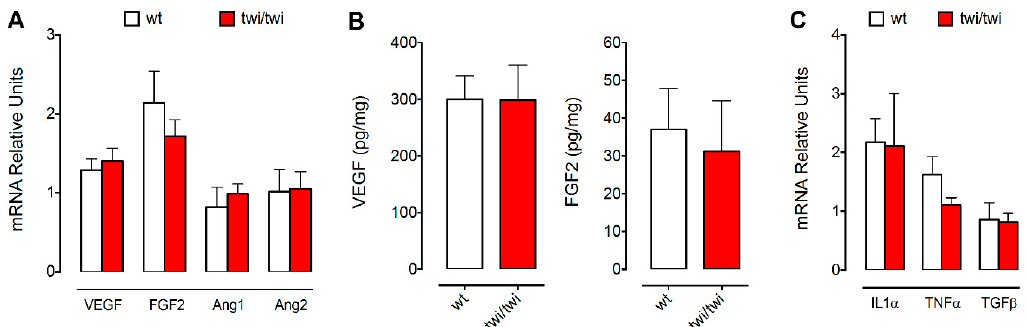
Figure 6. Quantification of pro-angiogenic and pro-inflammatory cytokines in the BM of twitcher mice. Pro-angiogenic ( A , B ) and pro-inflammatory cytokines ( C ) were quantified after BM flushing by ELISA ( B ; 3 animals per group) and RT-qPCR ( A , C ; 7–8 animals per group). Data are mean ± SEM.